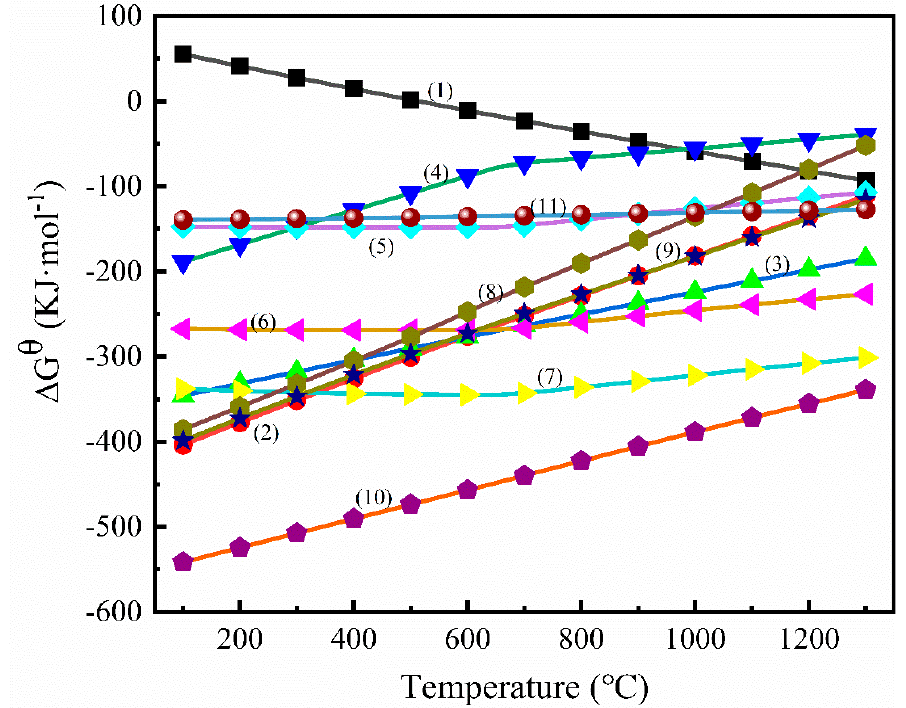
Figure 6. ∆ G θ — T diagrams for possible chemical reactions (Equations (1)–(11)). Figure 6. ∆ G θ − T diagrams for possible chemical reactions (Equations